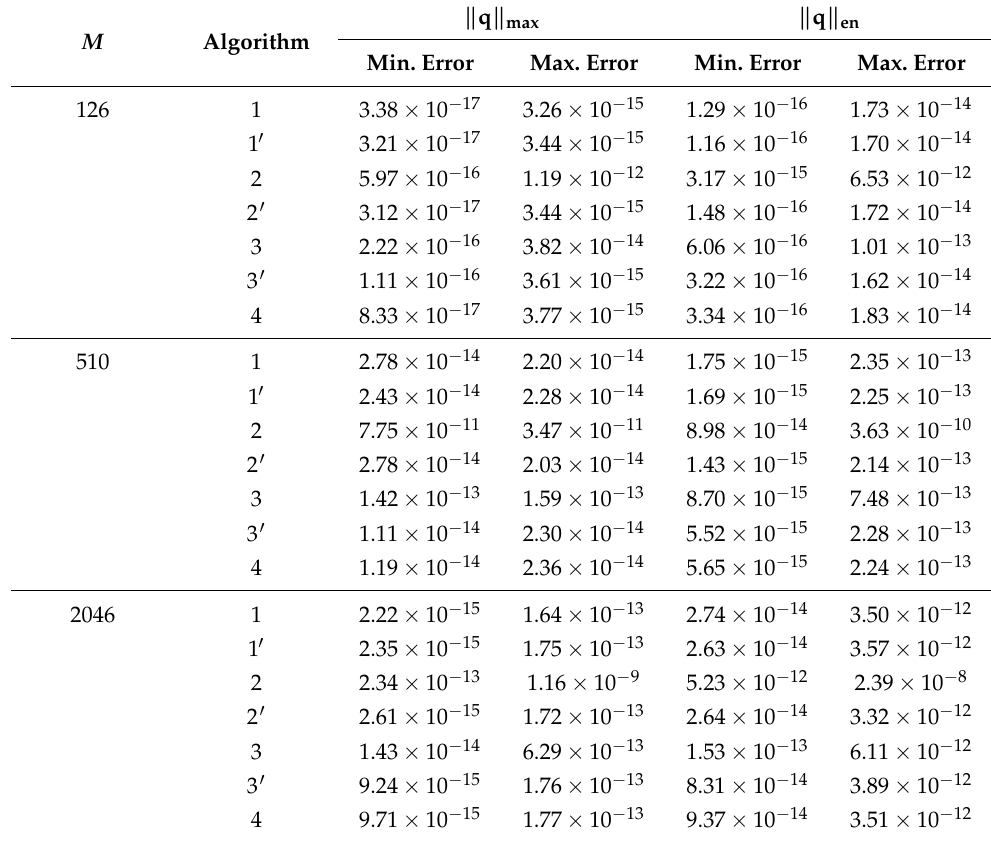
Table 1. Minimum and maximum error norms detected among solutions to the 10 6 test problems by the seven algorithms for determination of coefficients of a linear combination of the polynomials T (cid:63) n .